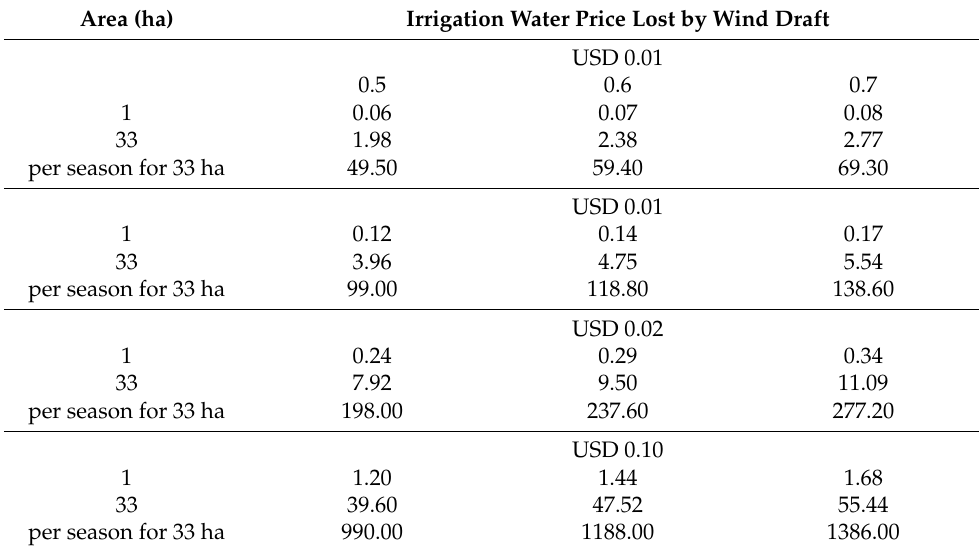
Table 4. Irrigation water price lost by wind drift during an irrigation event in center pivot irrigation. Area (ha)